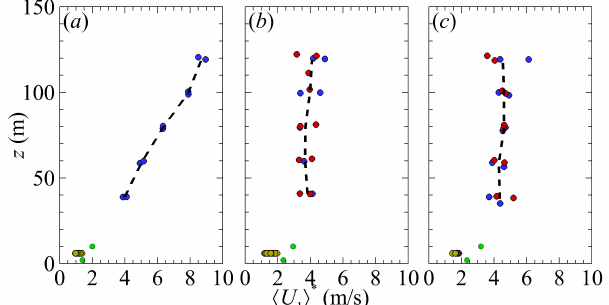
Figure 12. Vertical profiles of mean wind velocity measured during ( a ) flight 1, ( b ) flight 2, and ( c ) flight 3. The blue symbols indicate measurements made by BC5A, the red symbols indicate measurements made by BC5B, the olive symbols indicate measurements made by the sonic anemometer and the green symbols indicate measurements made by the Mesonet tower. The dashed line indicates the trend produced by averaging measurements at each altitude.